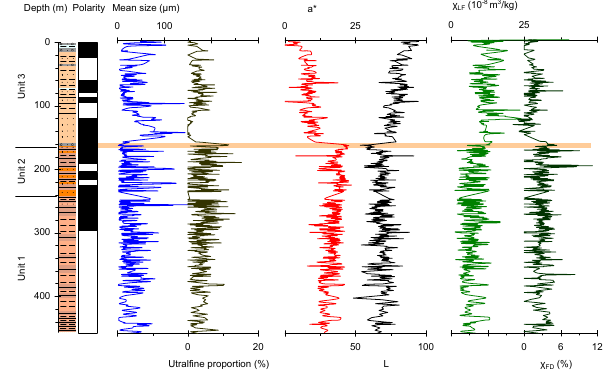
Fig.4 Fig. 4. Multi-proxy records of the HBS Section. The lithology types of the strata are the same as in Fig. 1. The grey bar indicates the boundary of the most dramatic changes in lithology and the multi- proxy